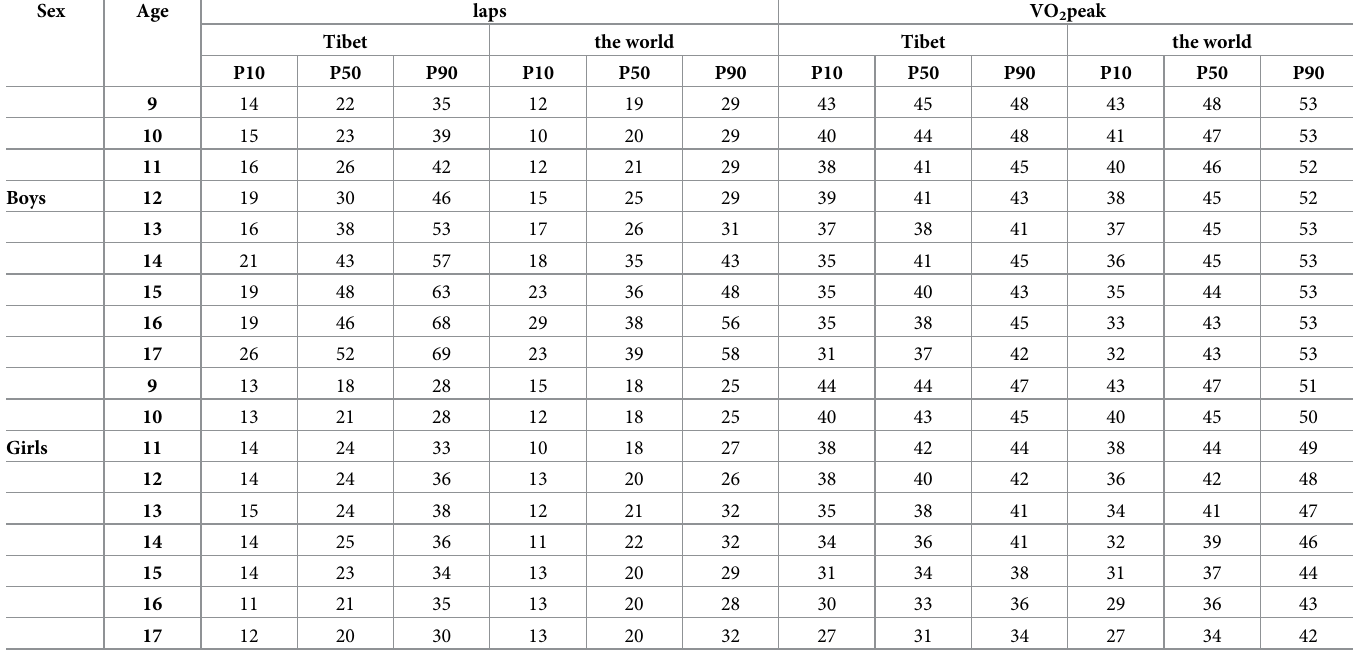
Table 4. 20m shuttle run test (20mSRT) performance (number of laps) and predicted VO 2 peak (mL/kg/min) centiles by age and sex in Tibet and the world’s stu- dents aged 9–17